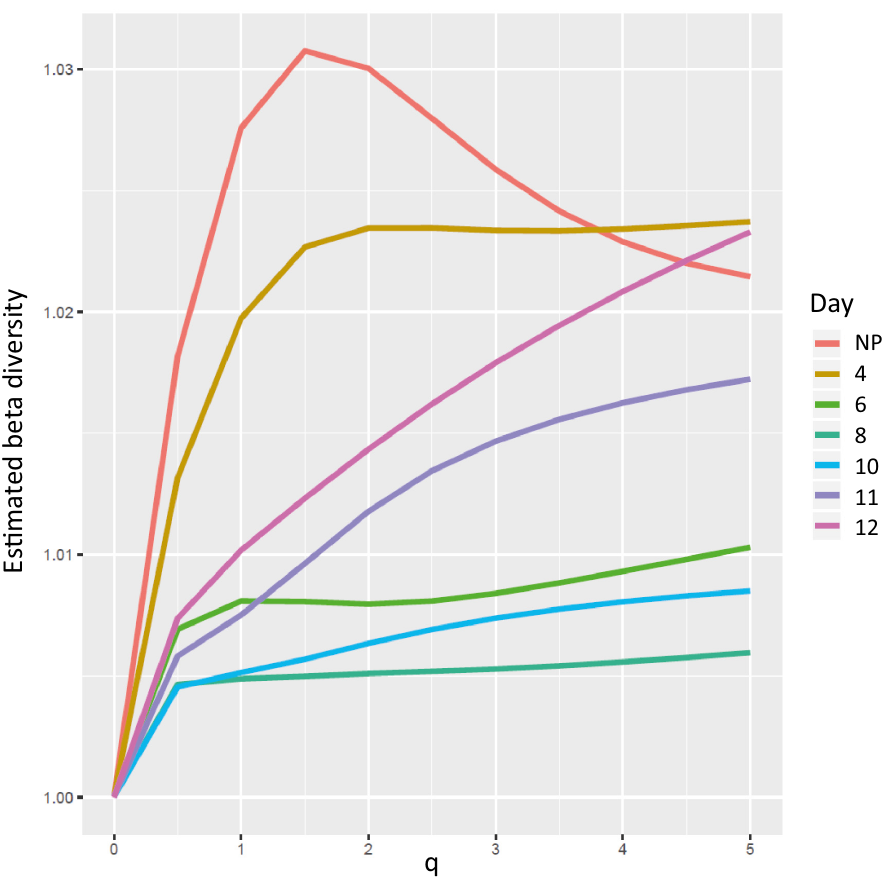
Fig 3. Beta diversity analysis as a function of q . Transcriptome analyses were performed on non-pregnant mice (NP), and at day 4 (D4), day 6 (D6), day 8 (D8), day 10 (D10), day 11 (D11), and day 12 (D12) as reported in Nehar- Belaid et al. 2016. For each set of profiles, beta diversity is calculated with DivEst function for q values between 0 and 5 with a step of 0.5. A beta diversity value of 1 corresponds to profiles having the same diversity for the given time-point.